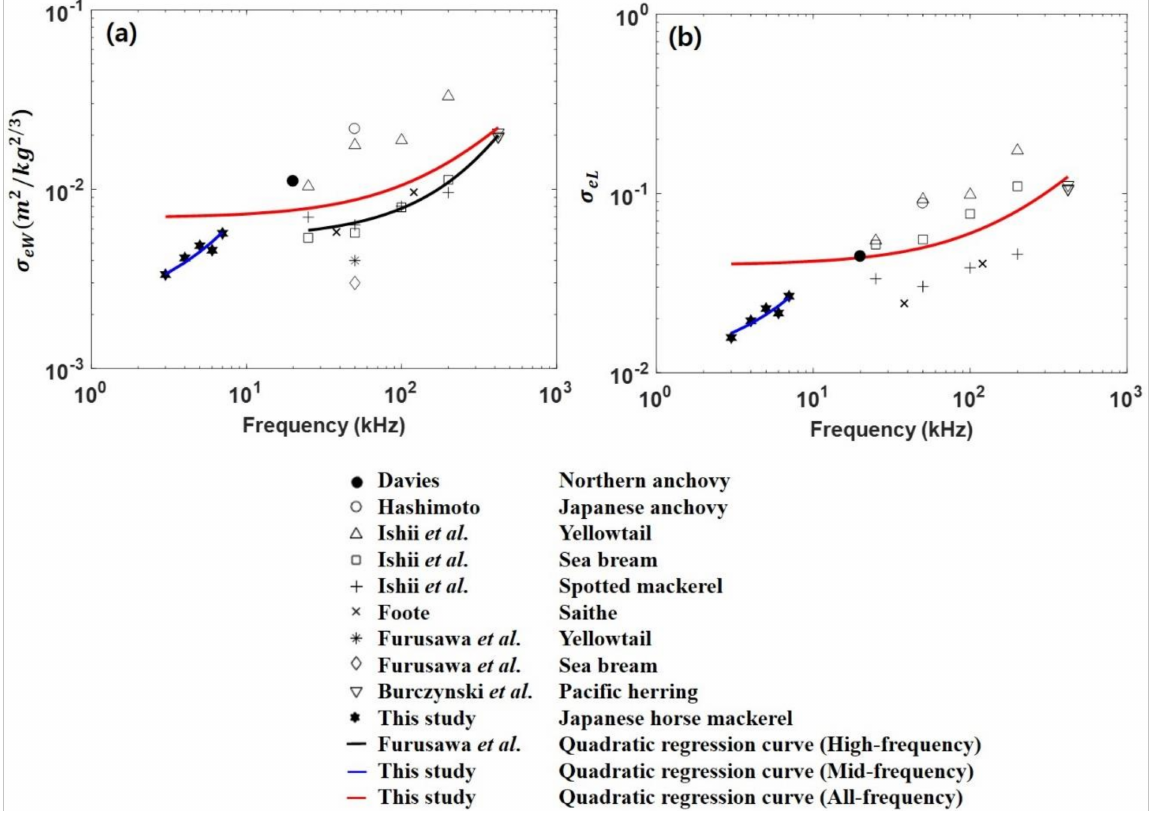
Figure 4. Results of normalized extinction cross-section of ( a ) the wet weight ( σ eW ) and ( b ) the total length ( σ eL ) of fish with frequency in previous and present studies. The black line is the previous regression model [6], the blue lines are the new quadratic regression models for mid-frequency from the present study, and the red lines are the total quadratic regression models for